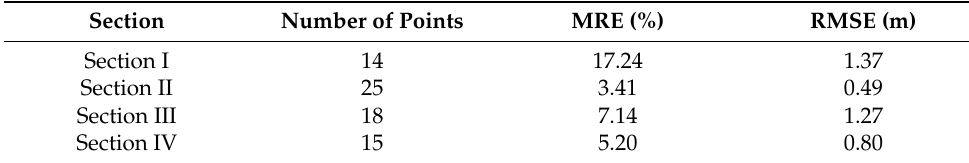
Figure 11. Comparisons between the measured and derived topographic data in ( a ) Section I, ( b ) Section II, ( c ) Section III, and ( d ) Section IV: the red lines are the measured topographic line, whereas the blue line corresponds to the derived topographic line. Table 1. The MRE and RMSE of the four sections.